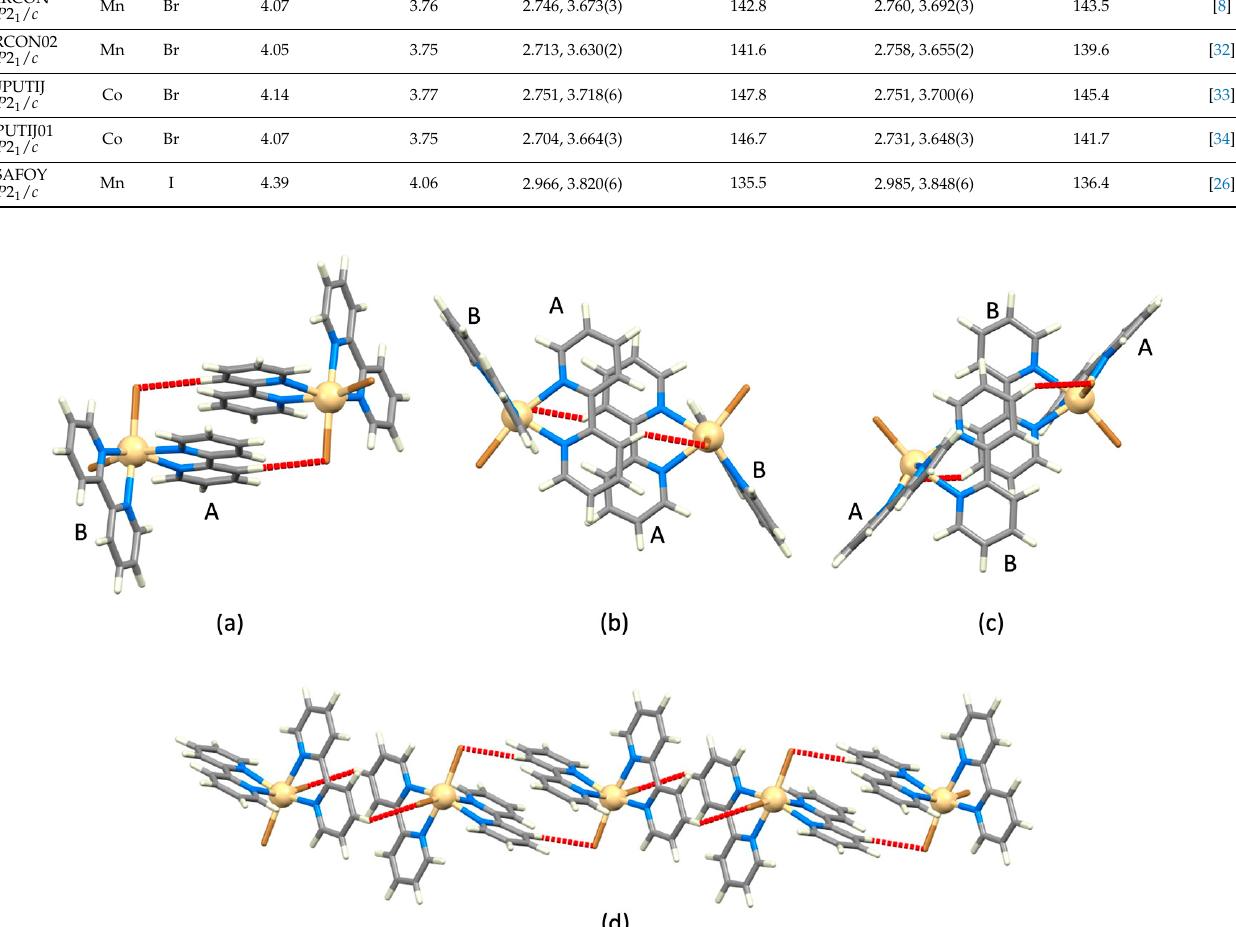
Figure 3. Primary packing motifs in the first group of non-solvated cis- [M(bpy) 2 X 2 ] illustrated with the structure of cis -[Cd(bpy) 2 Br 2 ] (CSD refcode DEYQUU01 [31]). ( a , b ) Two views of the centrosymmetric bpy A ...bpy A π -stacking interaction with H3...Br contacts (in red), ( c ) the centrosymmetric bpy B ...bpy B π -stacking interaction with H3...Br contacts (in red), and ( d ) heterochiral 1D-chains resulting from a combination of the two motifs. Table 3. Metric parameters for the face-to-face π -stacking and CH...X contacts in the packing motif in cis- [M(bpy) 2 I 2 ] (M = Cd, Ca). See Figure 4a.